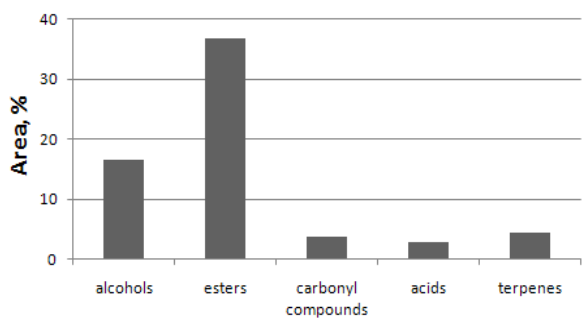
Figure 3: Profile of the most common organic compound classes in spirit distilled from Sorbus